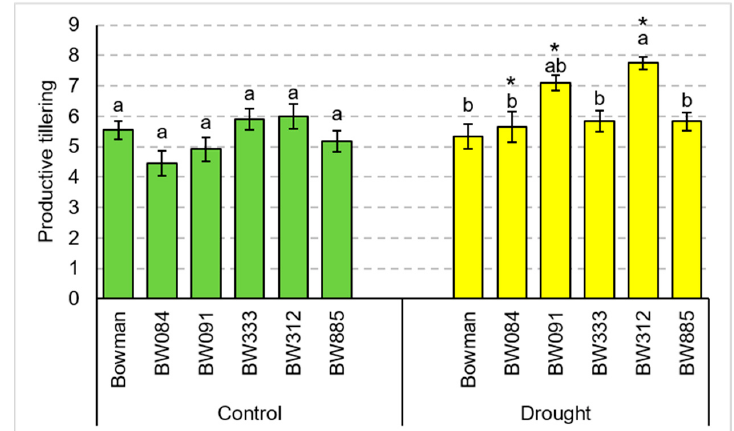
Figure 3 . Productive tillering (number of tillers with spikes) of the analyzed genotypes under the optimal watering (control) conditions and after the drought stress (the pot experiment). The mean values ± (SD) marked with the same letters (separately for the control and drought-stressed plants) are not significantly different, according to Duncan’s test ( p ≤ 0.05). Asterisks denote significant difference in comparison of values reported in each genotype between the control and drought conditions according to Student ’ s t -test. Details are given in the text.